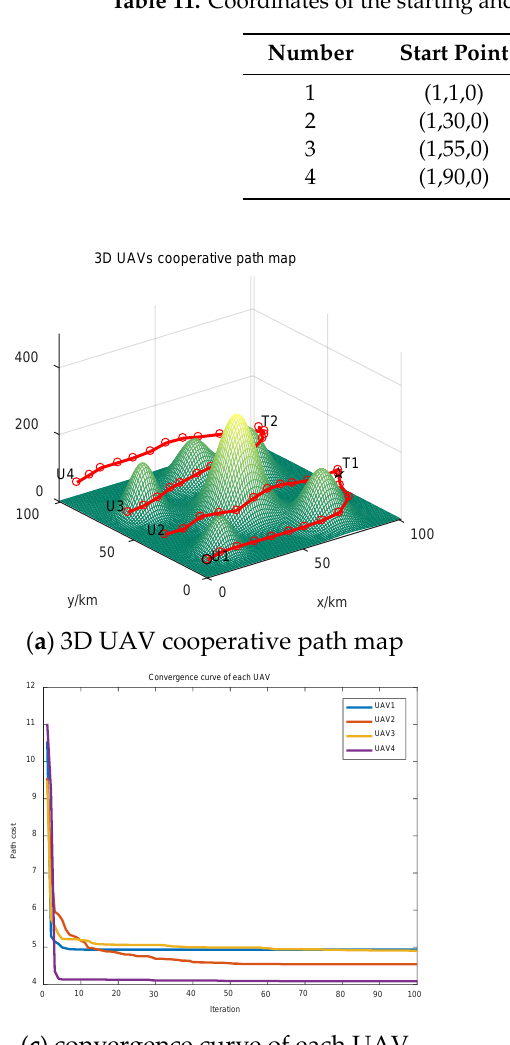
Table 11. Coordinates of the starting and target points of all UAVs (case 2).